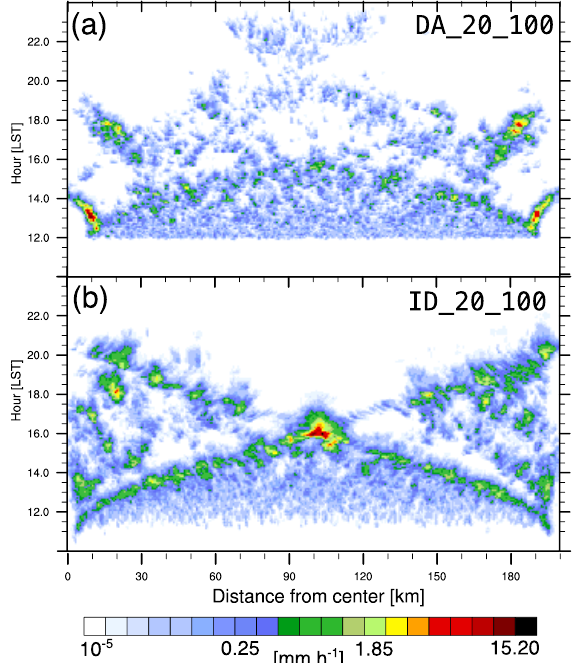
Figure 7. Hovmöller diagram of precipitation rate (mmh − 1 ) in cases (a) DA_20_100 and (b) ID_20_100